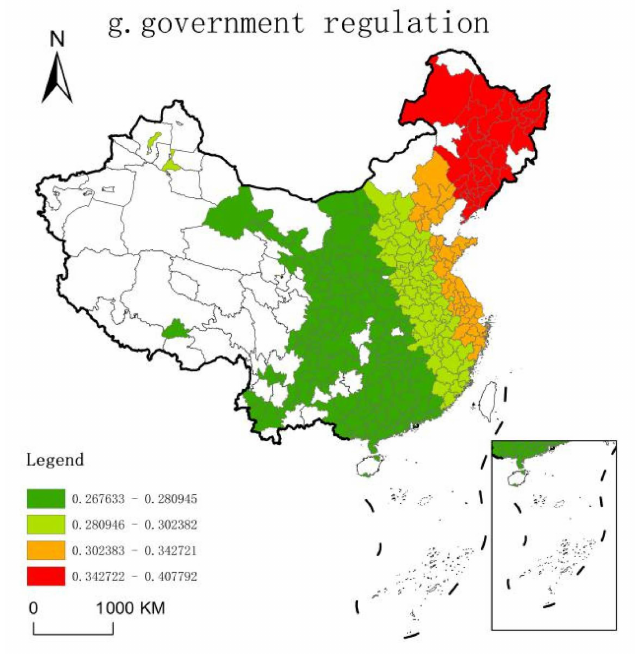
Figure 5. Spatial distribution of influencing